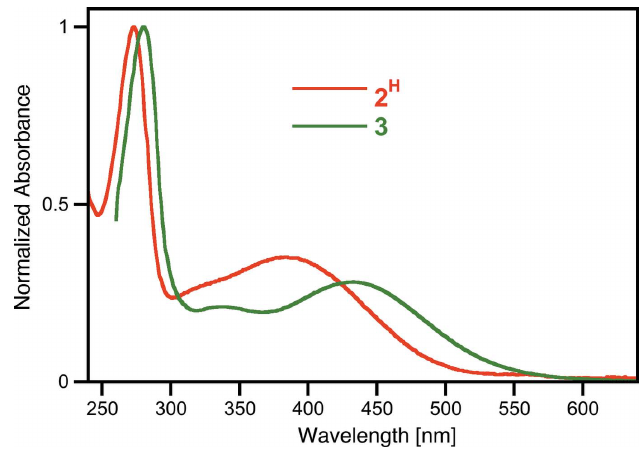
Figure 4 Normalized UV–vis spectrum of title compound 3 (DMSO) in comparison to that of the starting triscatecholate 1 (H 2 O).